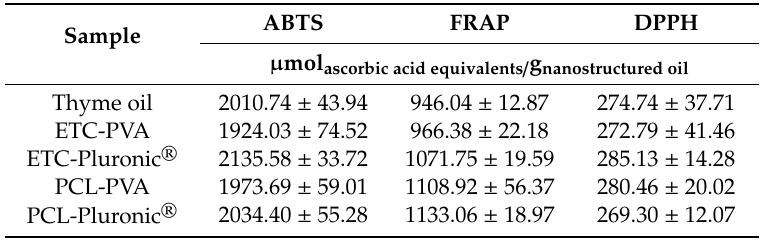
Table 3. Antioxidant capacity of the di ff erent polymeric nanocapsules obtained by the radicals ABTS, FRAP, and